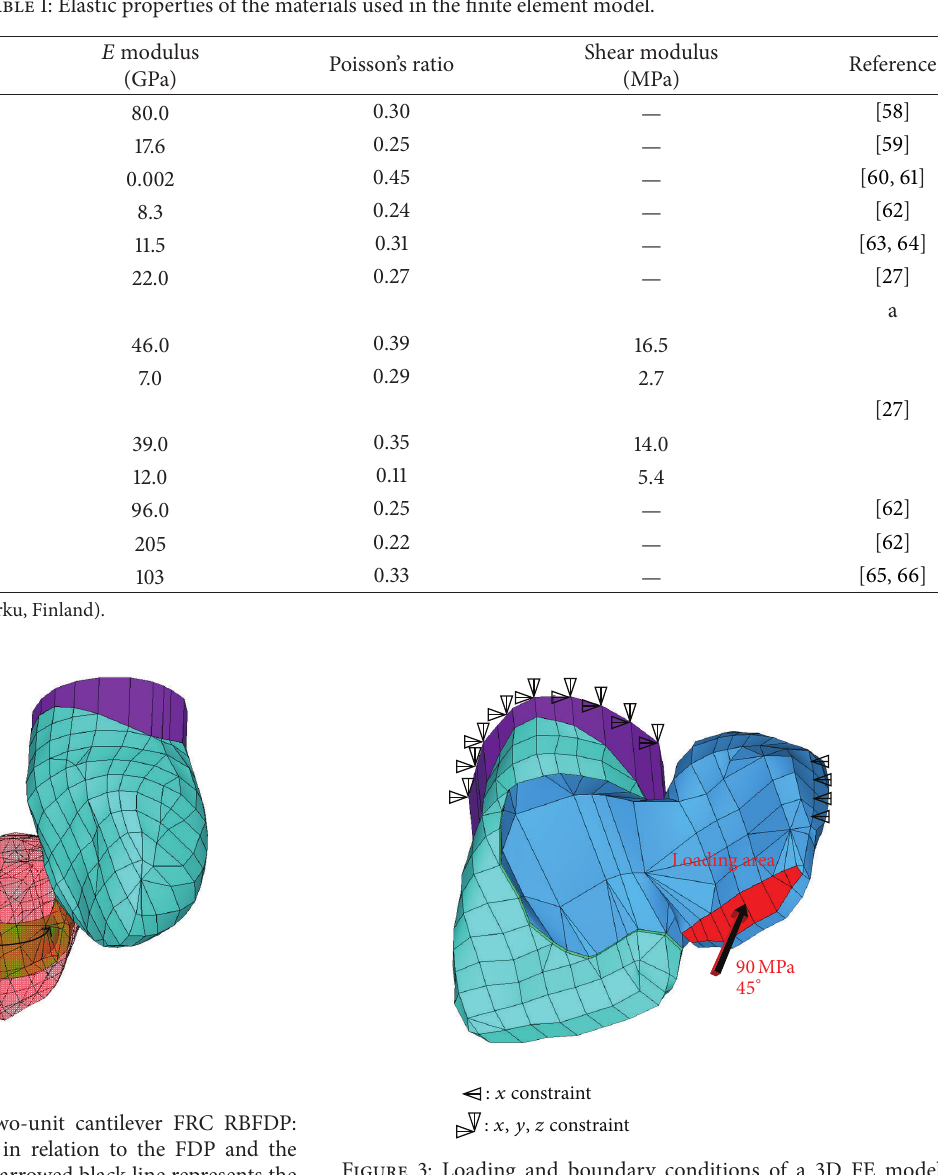
Figure 3: Loading and boundary conditions of a 3D FE model representing two-unit cantilever